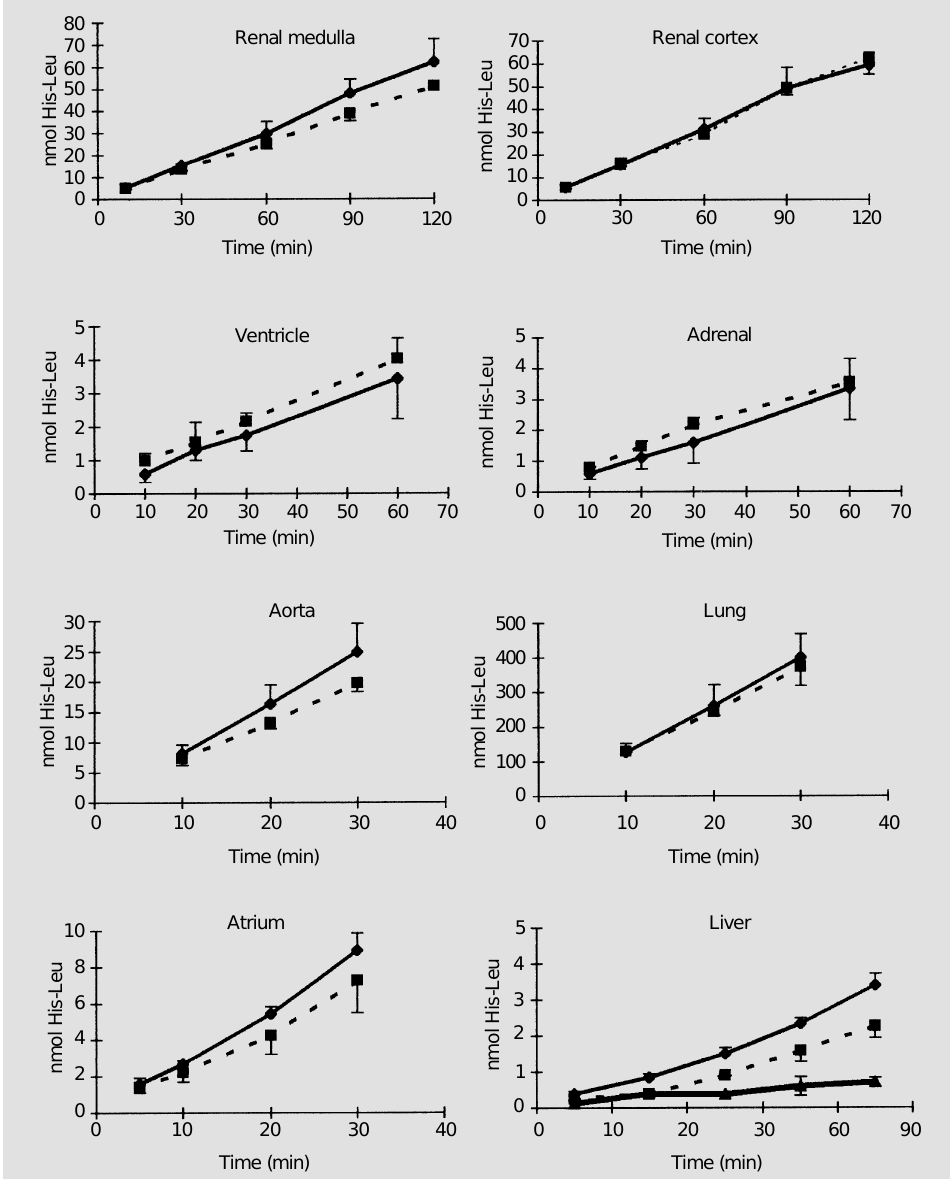
Figure 2 - Effect of incubation time on the formation of the His- Leu product by different tissue homogenates. His-Leu product formation was detected as de- scribed in Material and Meth- ods. Data are reported as the mean ± SD of three independ- ent experiments for SHR (squares) and Wistar (lozenges) rats. The effect of 100 µM PCMB treatment on the activity of liver homogenate is indicated by the